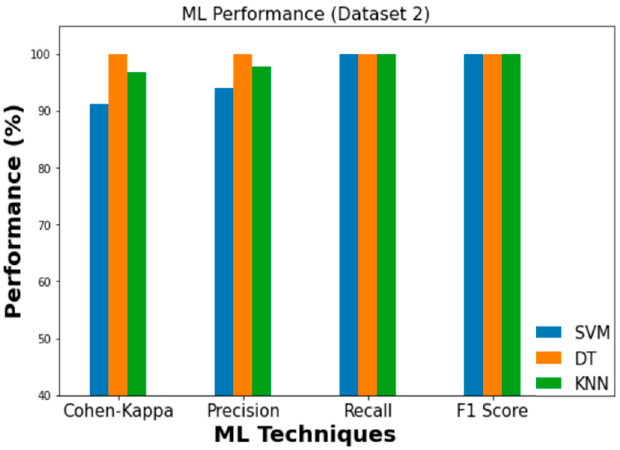
Figure 13. Performance comparison of ML (Dataset 2).